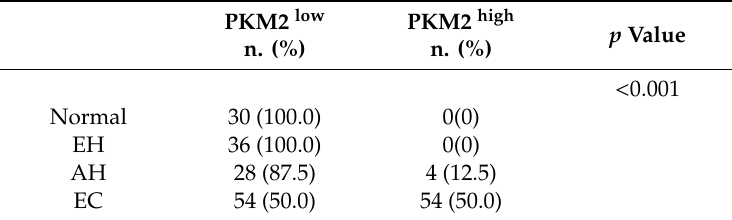
Table 1. The Chi-square test for pyruvate kinase M2 (PKM2) expression score based on the slide area and the intensity of color reaction.